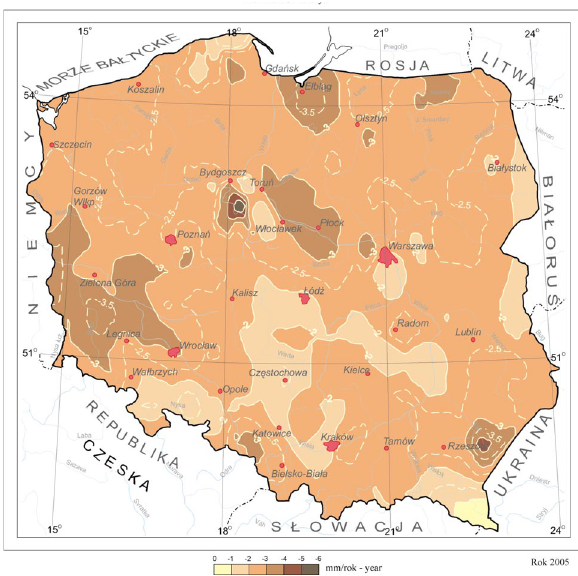
Fig 9. Model of vertical land uplift in the area of Poland, 2005 On the basis of the numerical model, the possibility exists of interpolating vertical movements anywhere in Poland. The first tests were carried out by Prof Adam